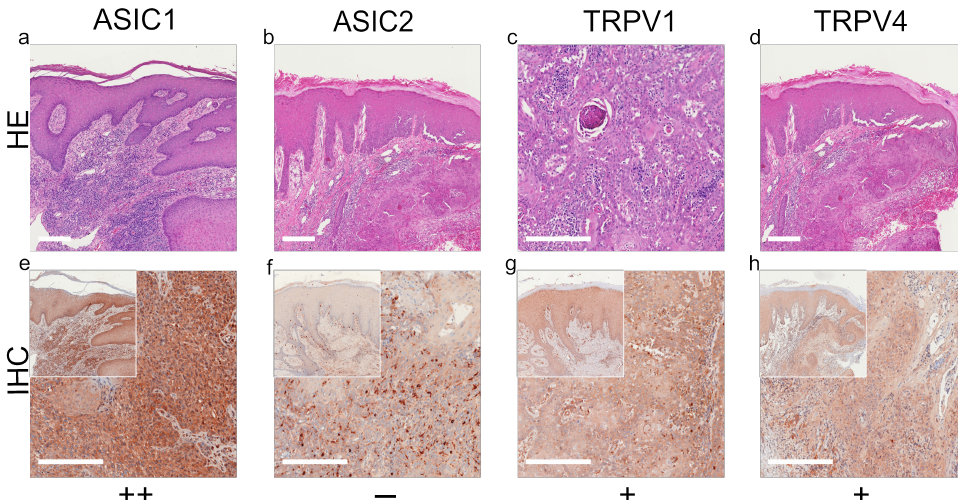
Figure 1. Immunohistochemistry of SCC. Immunohistochemical staining for ASIC1, ASIC2, TRPV1 and TRPV4 in SCC tissue. ( a – d ) H&E staining, ( e – h ) immunohistochemical staining, inserted smaller pictures represent a two times larger perspective. Scale bars represent 200 µm. ( a – h ) Patient 8. This SCC shows no expression of ASIC2, only some peritumoral lymphocytes appear positive. The tumor cells show a weak, positive expression of TRPV1 and TRPV4. ASIC1 is expressed strongly on tumor cells. For more stainings of other SCCs, see Supplementary Figures S1–S3.